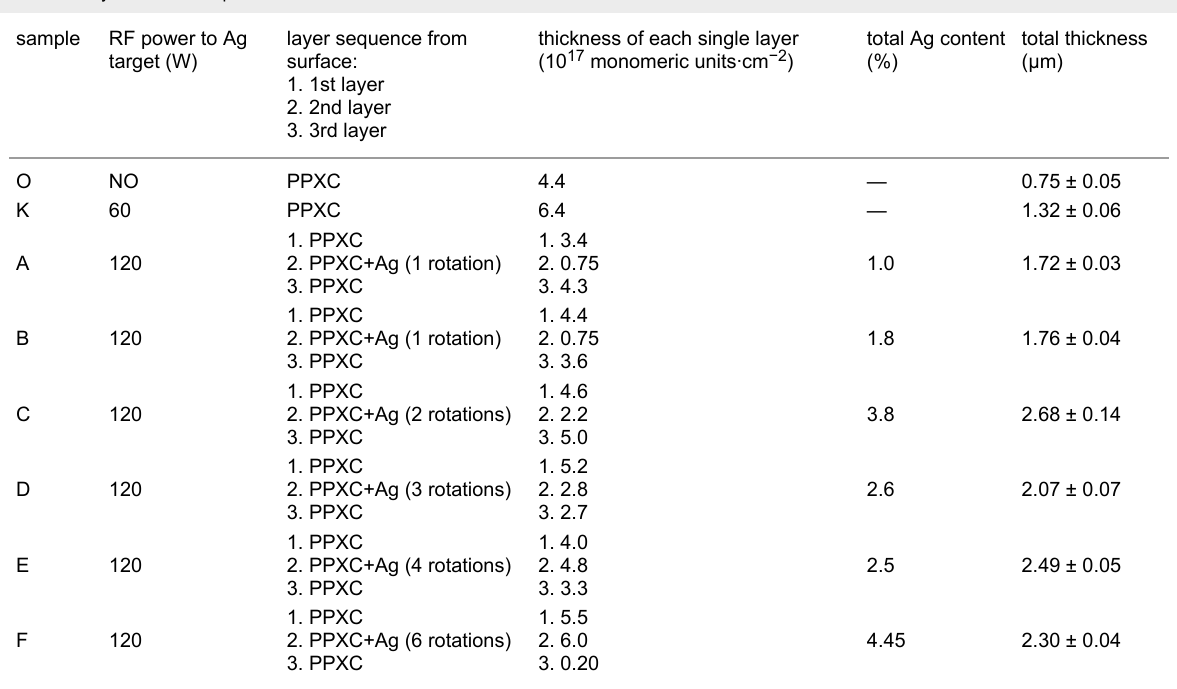
Table 1: Experimental parameters of pure parylene C and NCPCs deposited by combined CVD and RF sputtering at room temperature. The layer se- quence starts from the sample surface. The single layer thickness is measured in 10 17 monomeric units·cm − 2 . The total Ag content has been calcu- lated by dividing the Ag dose (in atoms·cm − 2 ) by the total parylene amount (in monomeric units·cm − 2 ). The total thickness (in µm, last column) was measured by a mechanical profilometer. sample